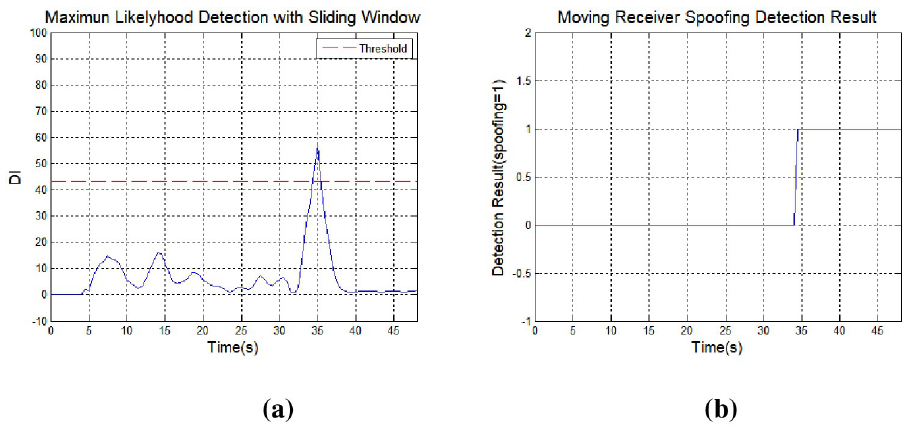
Fig 14. Spoofing signal detection results obtained using the sliding window method (single-channel spoofing): (a) DI and (b) detection results.